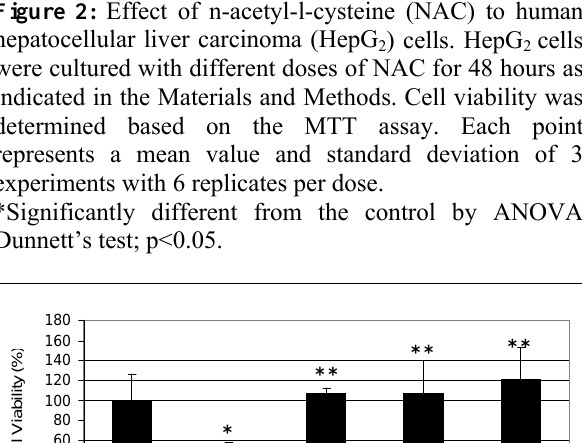
) cells. HepG cells 2 2